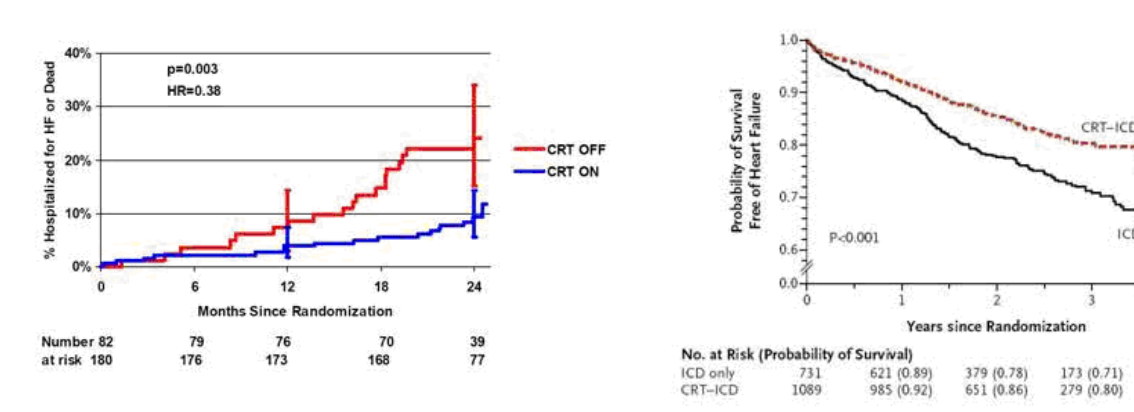
Reduction in all-cause death or HF hospitalisation in patients with mild HF in the REVERSE (left) and MADIT- CRT (right) trials, respectively. Reproduced with permission from references Fehler! Textmarke nicht definiert. and Fehler! Textmarke nicht definiert.